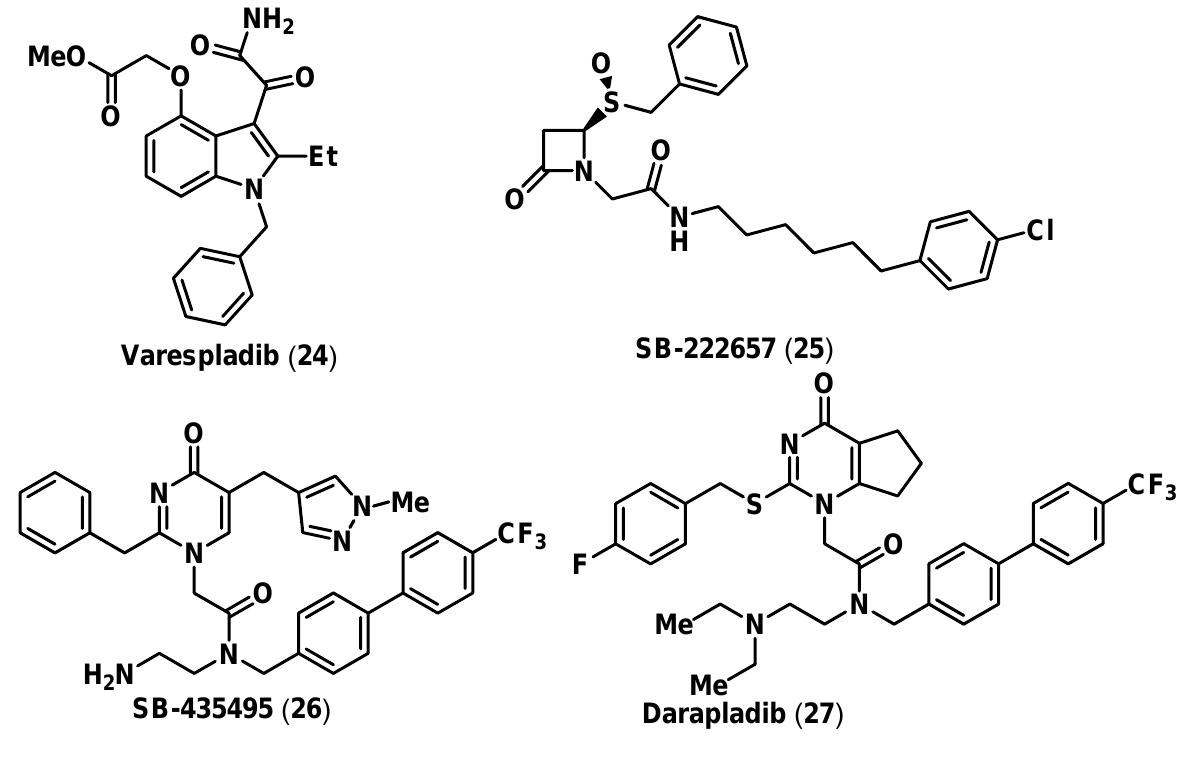
Figure 6. Chemical structures of some representative PLA